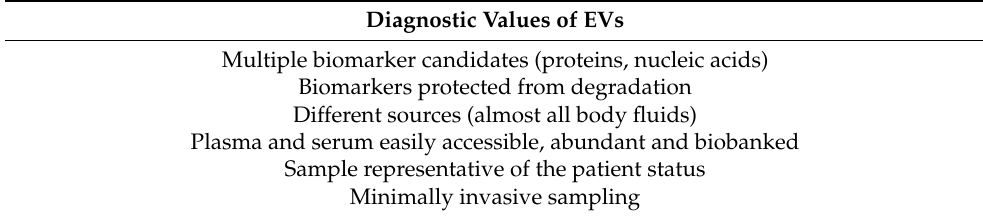
Table 1. Features that make EVs potential diagnostic